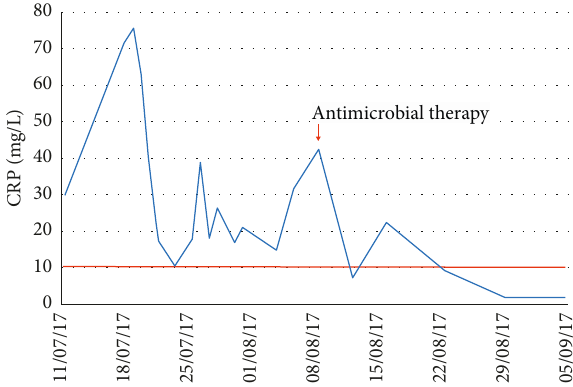
Figure 3: Course of CRP (mg/l) in case number